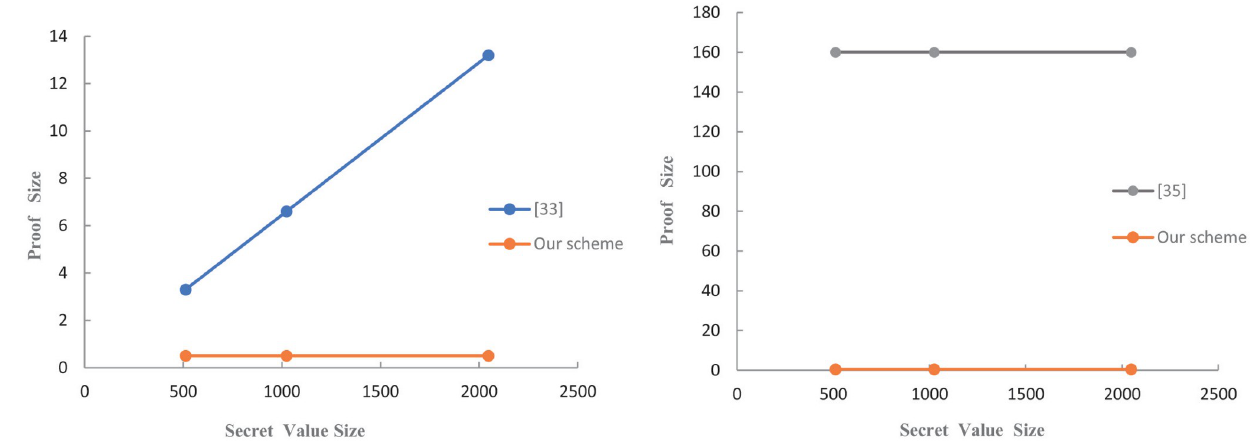
Fig 5. Impact of the secret value size on proof